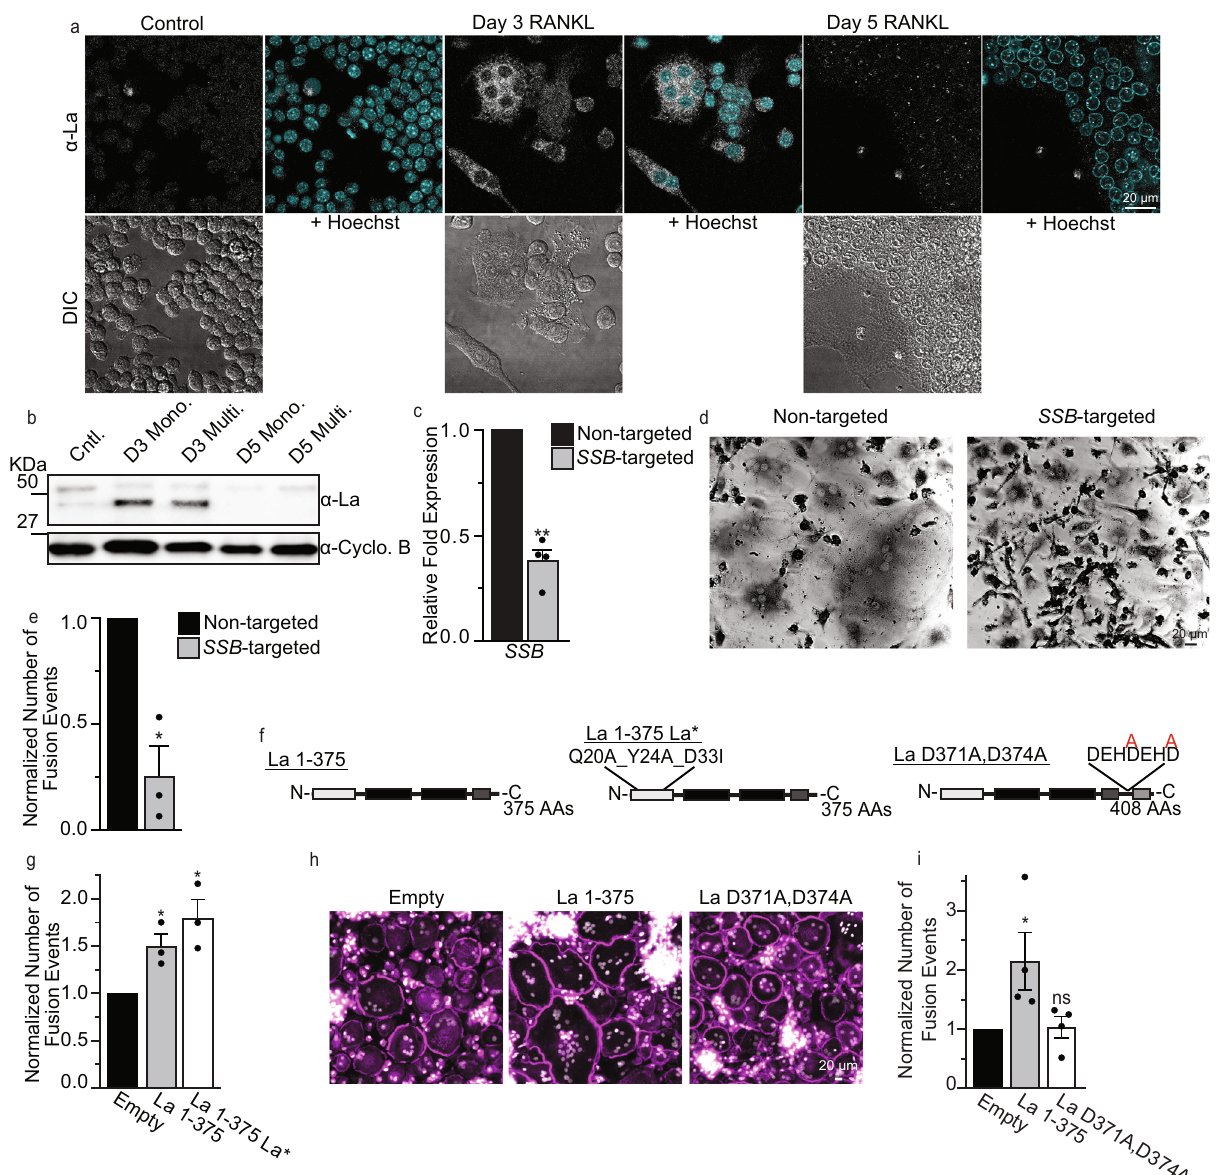
Fig. 2 | Osteoclast formation depends on truncated La, but the function ofthe La domain is dispensable. a Representative immuno fl uorescence images of La in RAW 264.7 prior to mRANKL addition (Cntl.), 3 days post mRANKL addition and 5 days post mRANKL addition when we routinely observe massive, multinucleated osteoclasts like the one imaged here. ( α -La mAb) . b Representative tris-glycine Westernblotof wholecelllysatestakenfrom murine,RAW264.7 treated asin a ( α - La rAb). mRANKL-treated cells were enriched into mononucleated (Mono.) or multinucleated(Multi.)populationsasdescribedintheMethods.(CyclophilinB( α - CycloB)loadingcontrol). c qPCRevaluationof SSB inhumanosteoclastprecursors